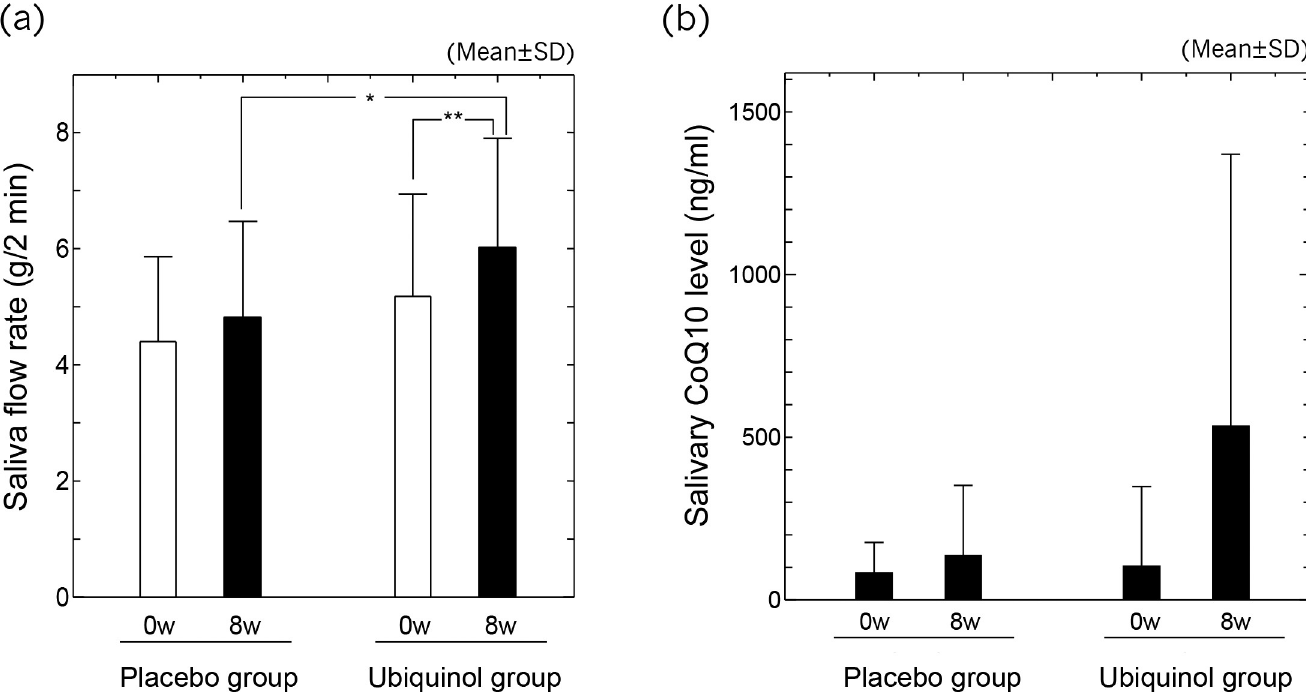
Fig 3. Saliva flow rate and salivary CoQ10 level before and after the study. The saliva flow rate (a) and salivary CoQ10 level (b) in the placebo group (n = 20) and the ubiquinol group (n = 18) before (0w) and after (8w) the treatment period. Values are presented as the mean ± standard deviation. Significant differences: � p < 0.05, �� p < 0.01.